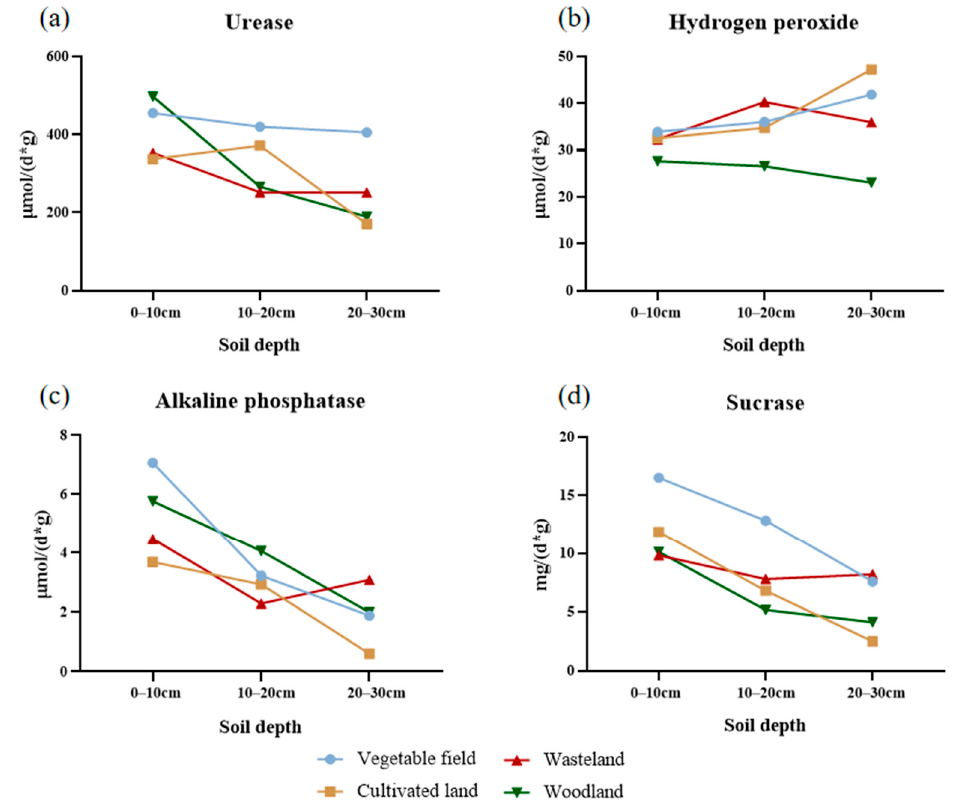
Figure 4. Changes in ( a ) soil urease, ( b ) soil hydrogen peroxide, ( c ) soil alkaline phosphatase, and ( d ) soil sucrase activity under different land use types in the Taojia River basin.